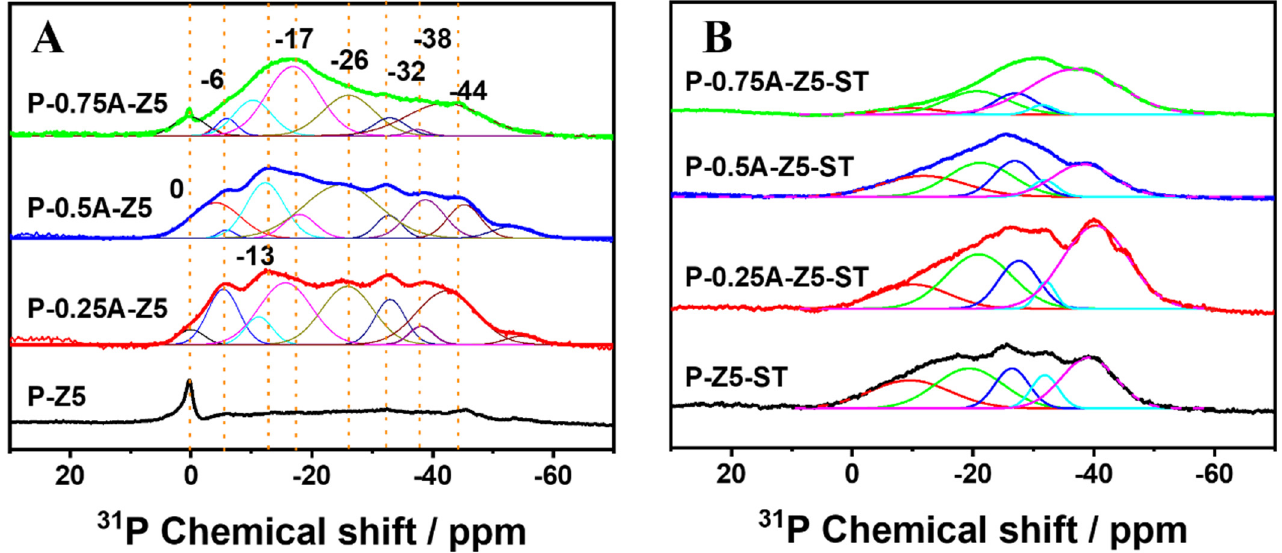
Figure 7. The 31 P MAS NMR of the ( A ) P-xA-Z5 and ( B ) P-xA-Z5-ST samples. Table 6. Integral peak-fitting results of 31 P MAS NMR for the P-xA-Z5